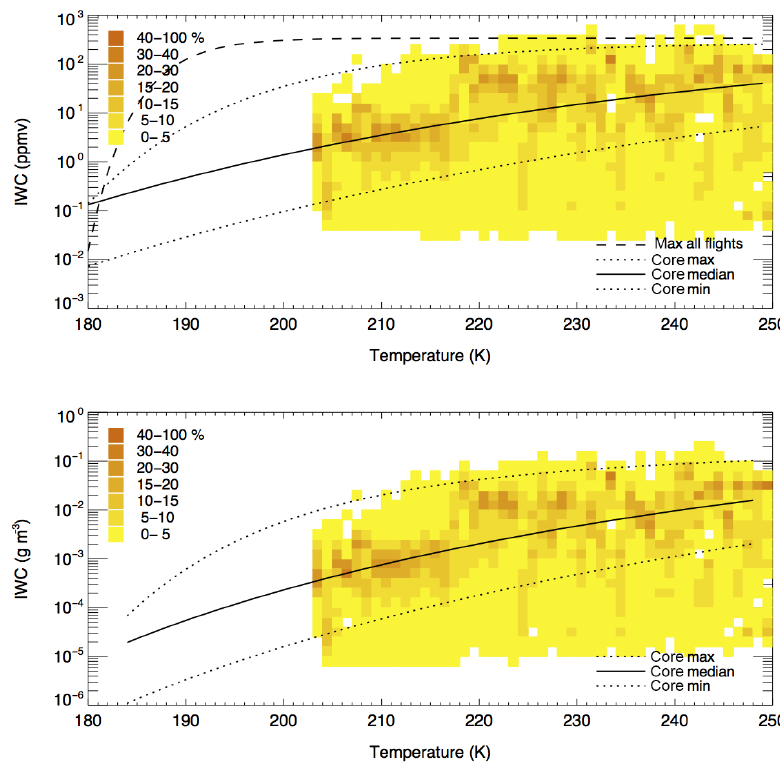
Figure 5. The frequency of IWC observations as a function of temperature for 15 flights from the ML-CIRRUS campaign. IWC is plotted in 1K temperature bins and is show in ppmv (top) and gm − 3 (bottom). The core max, median, and core min lines (black) are from Schiller et al.